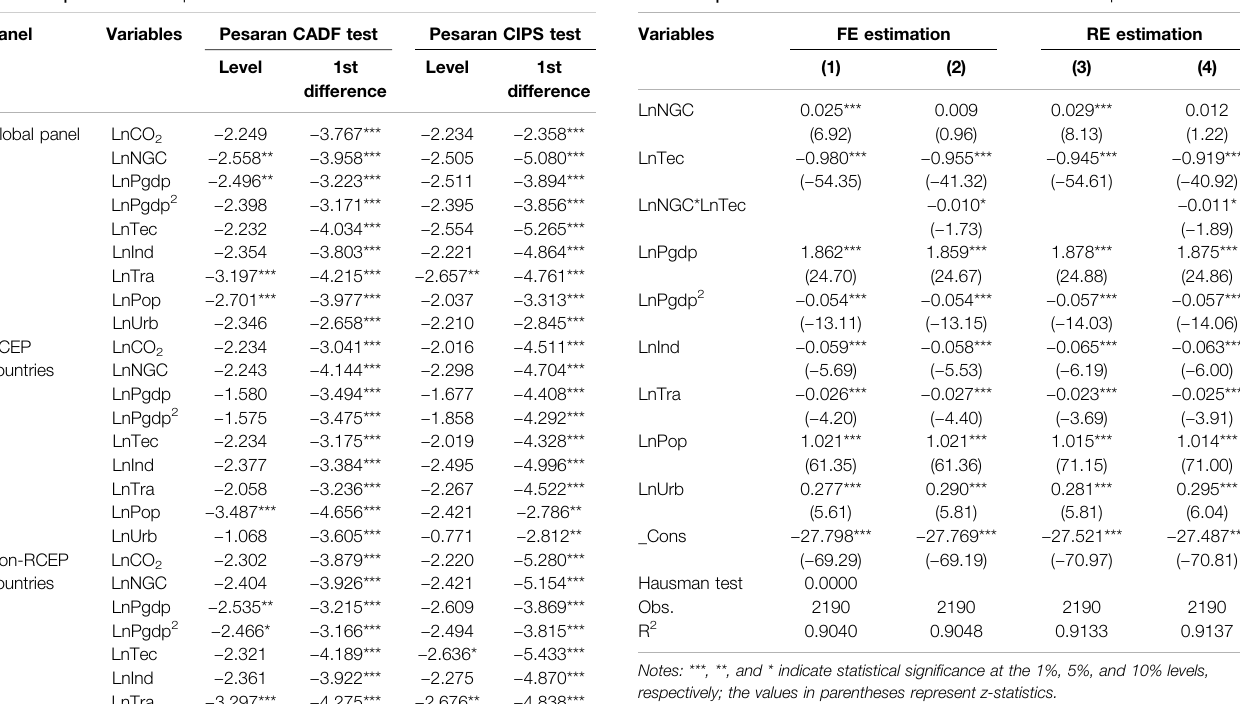
TABLE 5 | Results of the FE and RE estimates for the full